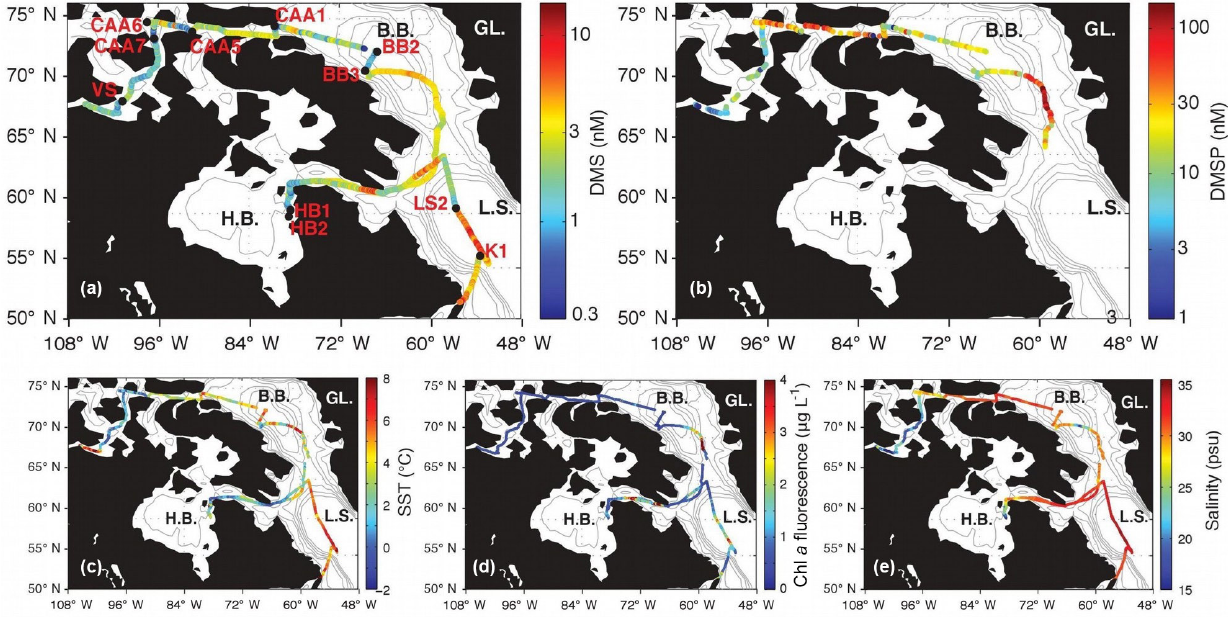
Figure 1. Spatial distribution of DMS, DMSP and hydrographic variables. GL. is Greenland, B.B. is Baffin Bay, L.S is Labrador Sea, H.B. is Hudson Bay, and C.A.A. is Canadian Arctic